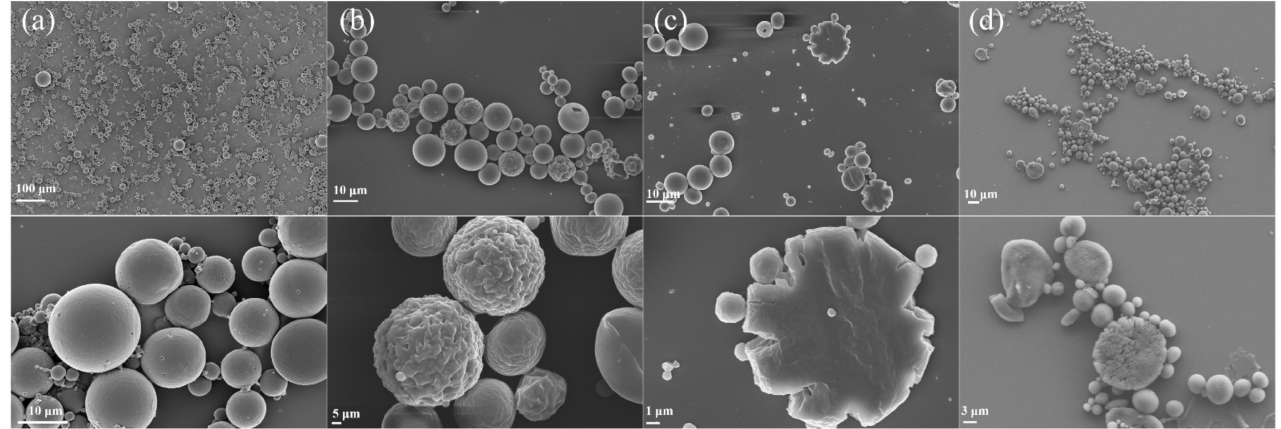
Figure 8. FE-SEM images of microspheres using PCL-b-PLA-b-PMVK (entry 2) according to UV irradiation time: ( a ) 0 h; ( b ) 2 h; ( c ) 4 h; ( d ) 6 h.